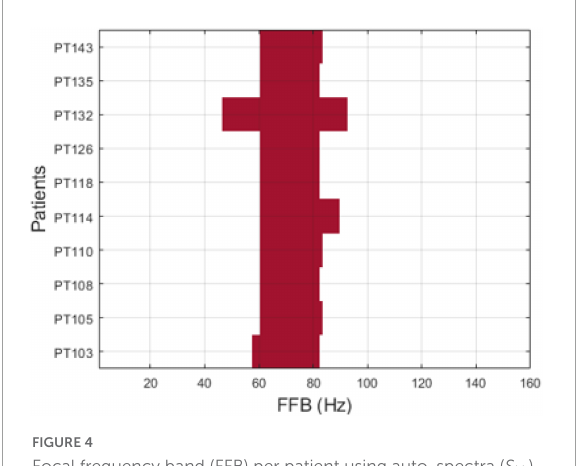
FIGURE4 Focal frequency band (FFB) per patient using auto-spectra ( S kk ) measure of power.